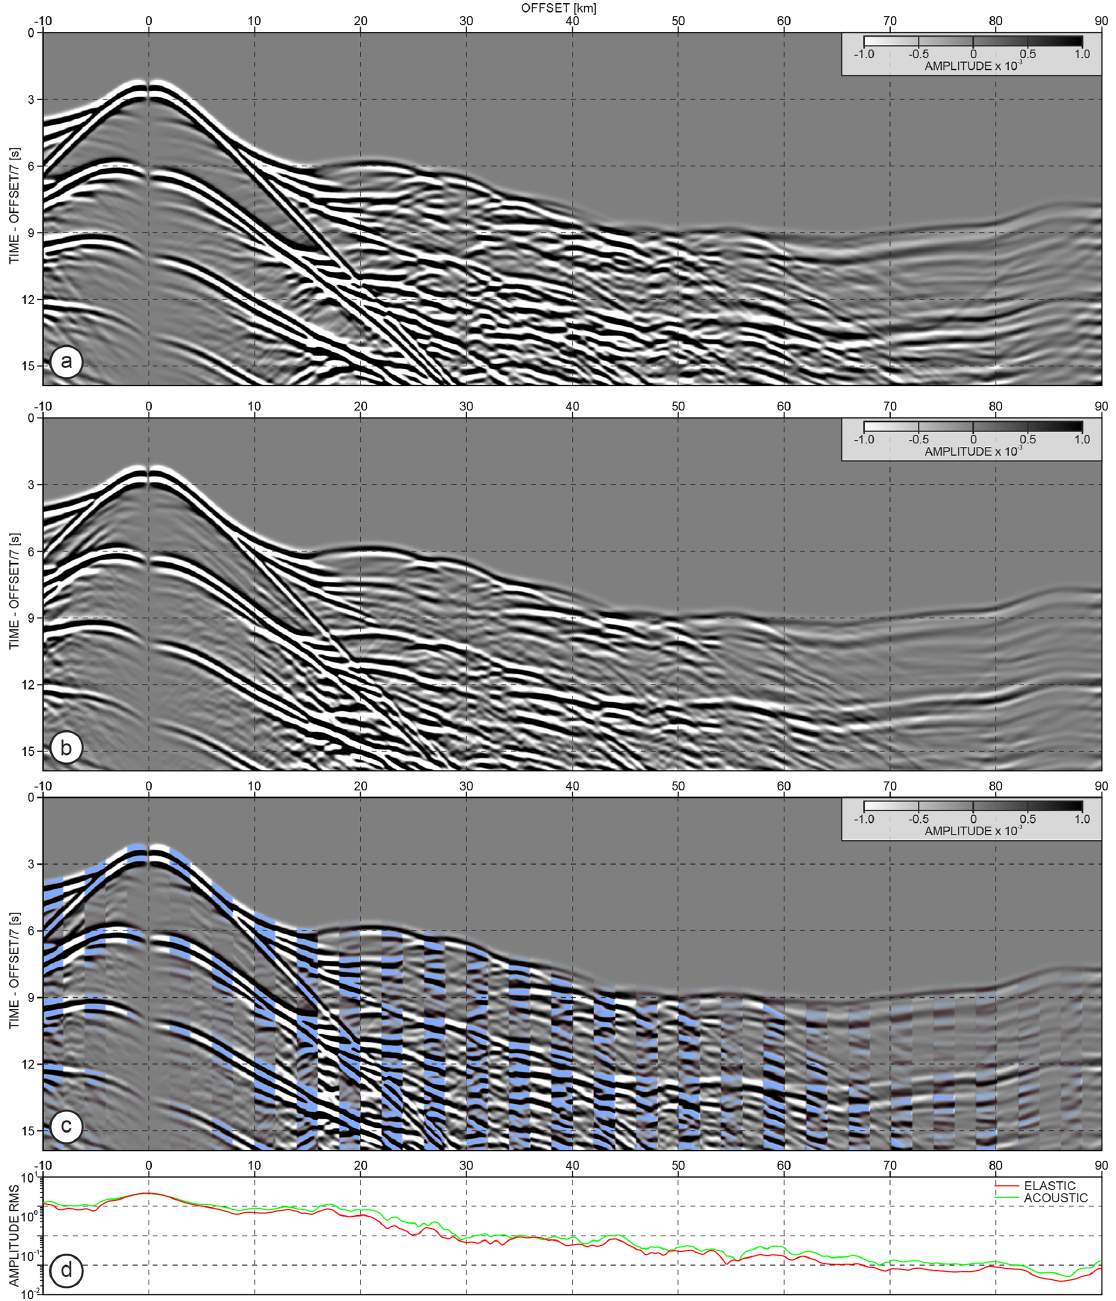
Figure 13. OBS gathers generated using 3D spectral-element (a) acoustic and (b) elastic waveform modelling. (c) Comparison of seis- mograms from (a, b) where 20 traces from acoustic modelling (light-blue shading) are interleaved with the following 20 traces from the elastic equivalent. For better readability, the seismograms are scaled with the absolute offset value. (d) Rms amplitude curves of the gathers from (a, b) – without scaling with